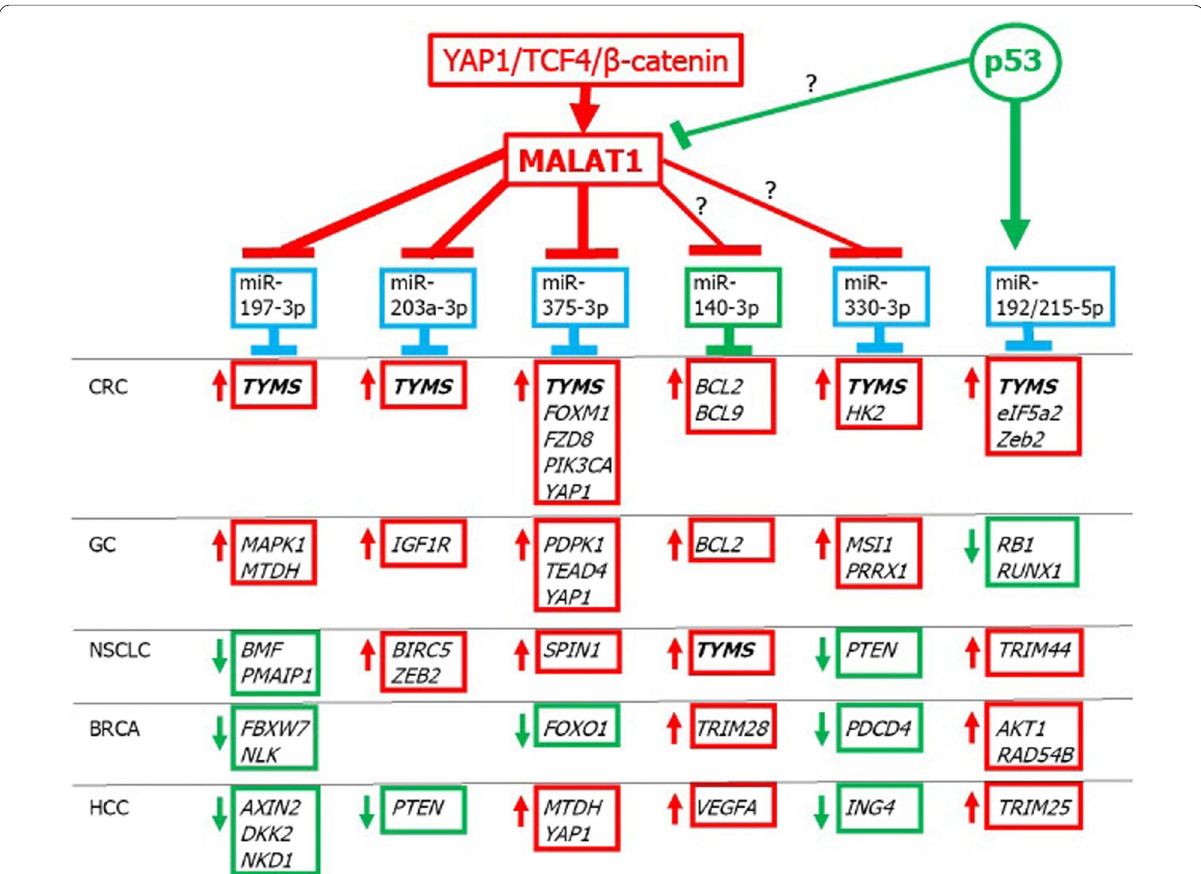
Fig. 3 MALAT1-miRNAs network regulating the expression level of TYMS along with other cancer-related genes in various types of cancer. Cancer type designation: CRC, colorectal cancer; GC, gastric cancer; NSCLC, non-small cell lung cancer; BRCA, breast cancer; HCC, hepatocellular carcinoma. Red indicates oncogenic effects, green indicates tumor suppressor effects, blue indicates tumor suppressor or oncogenic effects depending on the type of cancer. YAP1 in complex with TCF4/β-catenin upregulates the expression of the MALAT1 gene in CRC and HCC (Sun et al. 2019b; Wang et al.